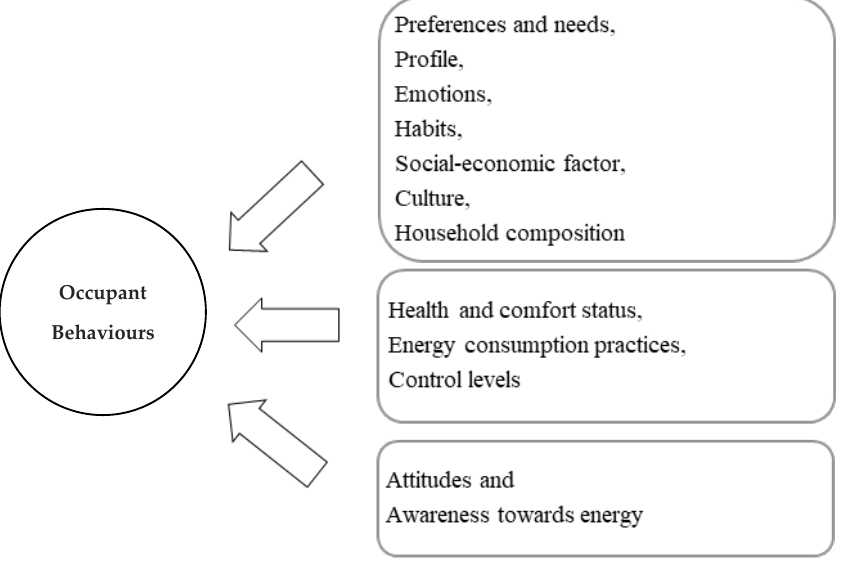
Figure 1. Effective factors on occupant behaviours energy use [26, 27, 30, 39].